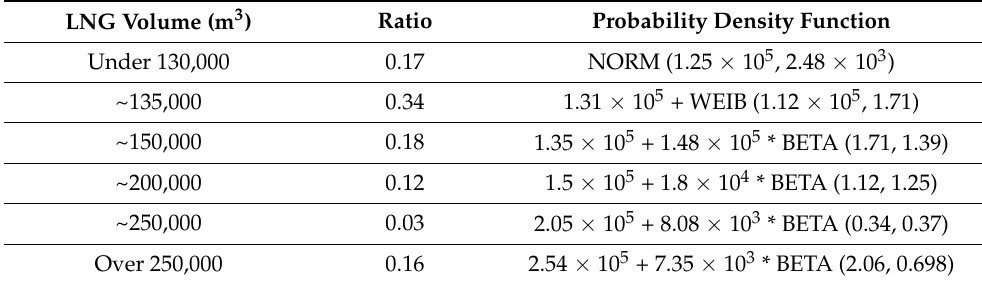
Table 4. Distribution of LNG volume of calling ship.